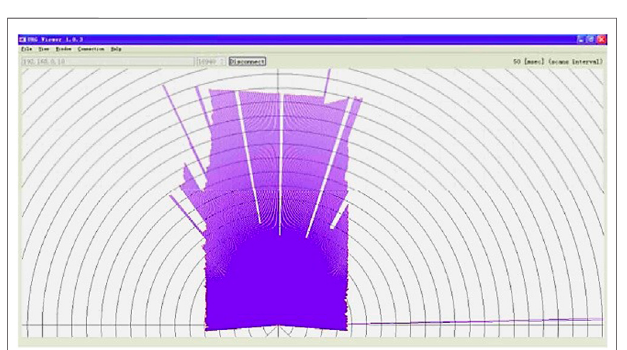
FIGURE 3 | Raw data collected by radar.